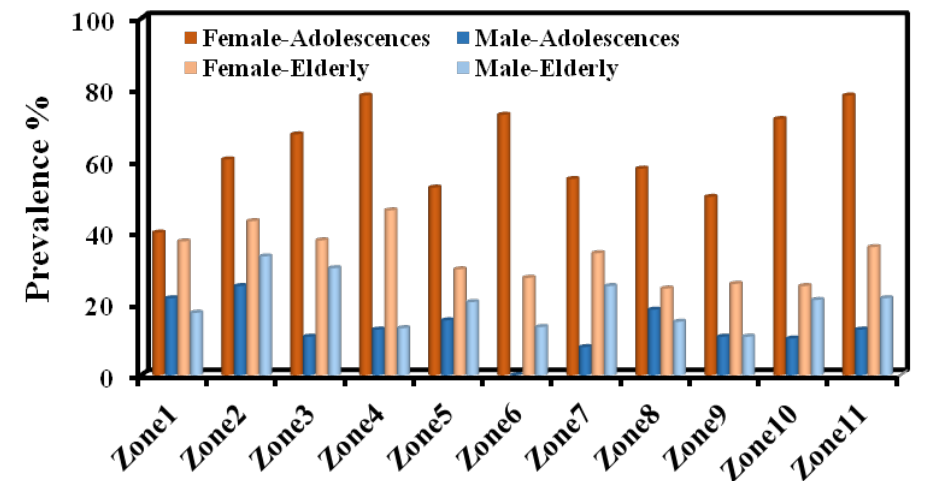
Figure 1 supplementary. The status of vitamin D deficiency according to geographical regions, specific age groups and sex; Study Poura, Spring